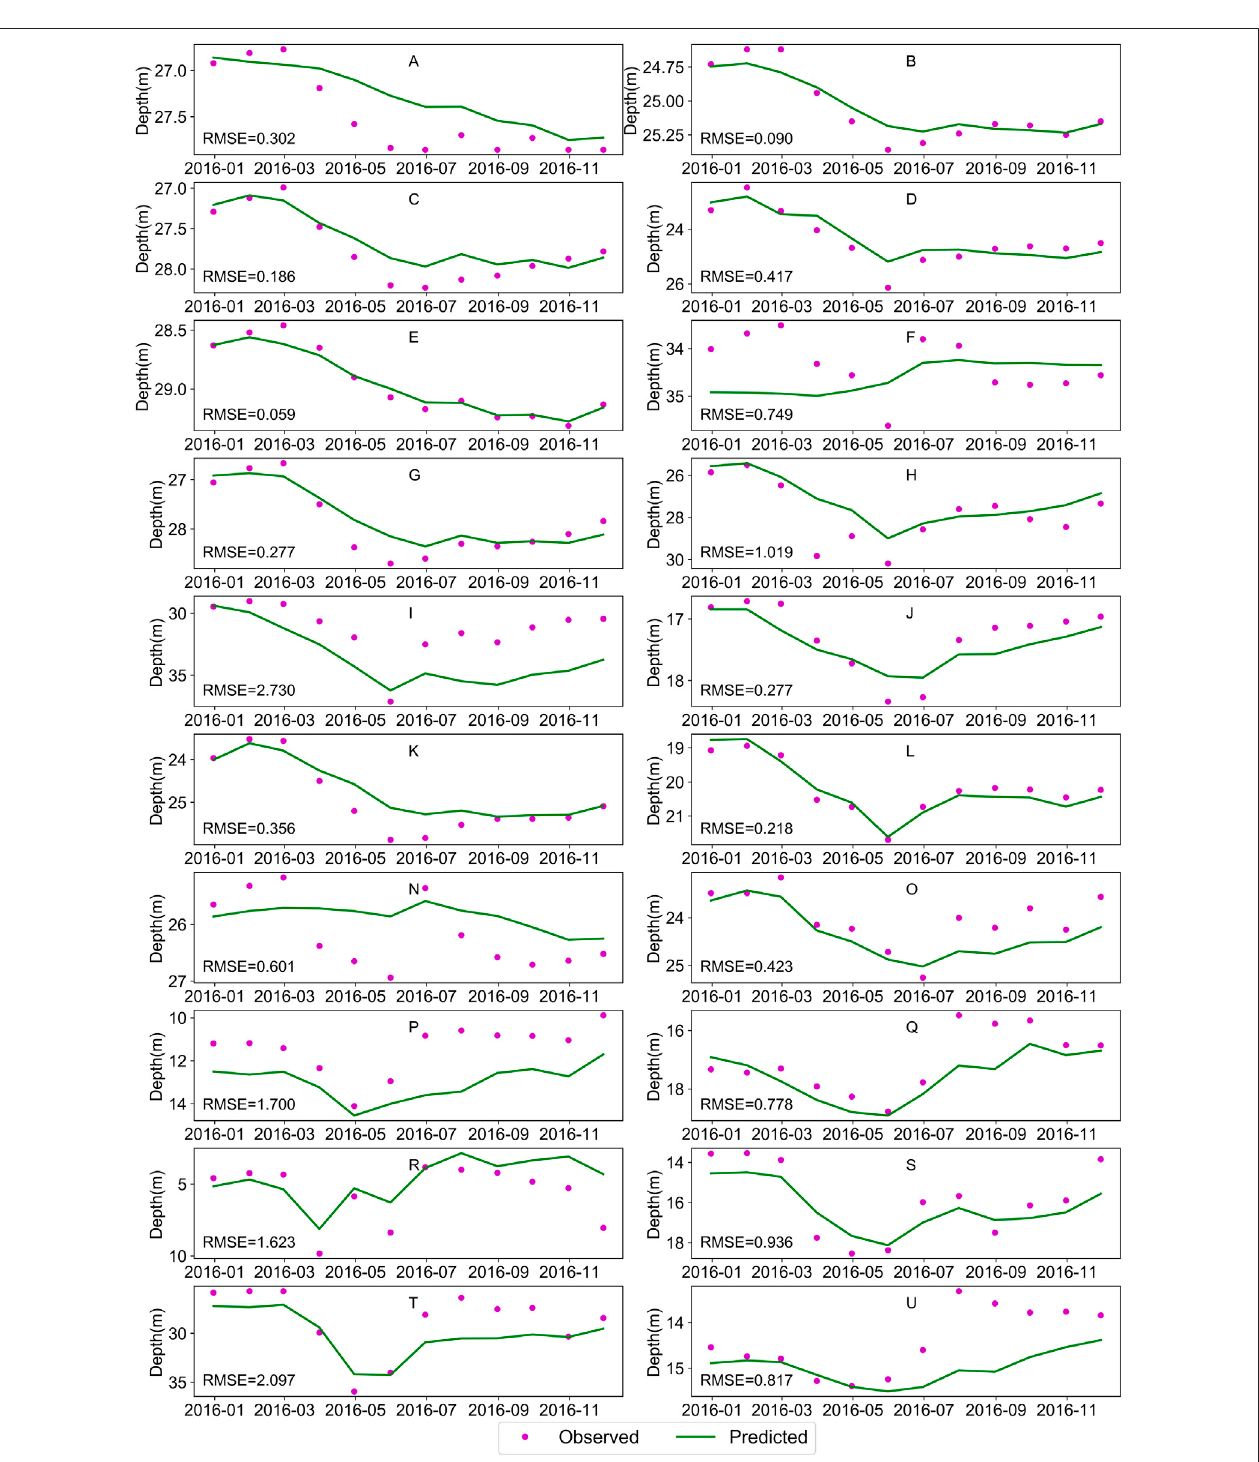
FIGURE 11 | Recursive prediction using wavelet-LSTM model for 1 – 12 months.